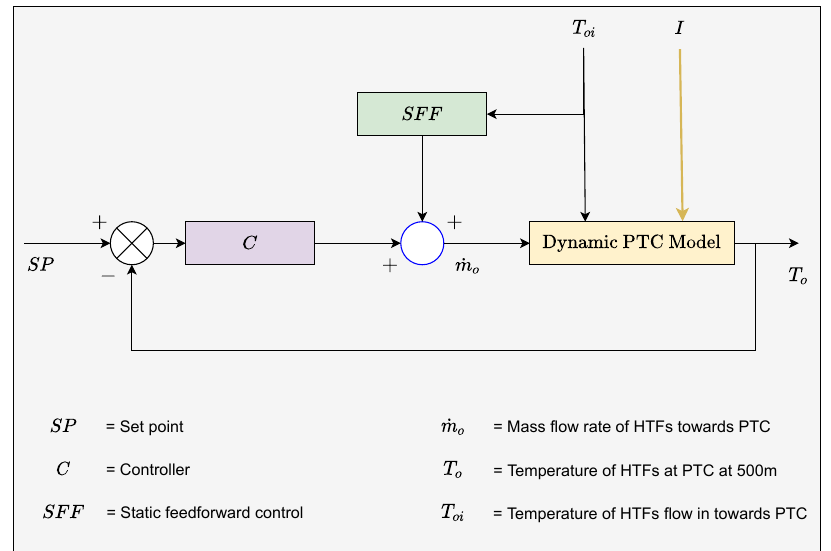
Figure 7. Control loop structure of